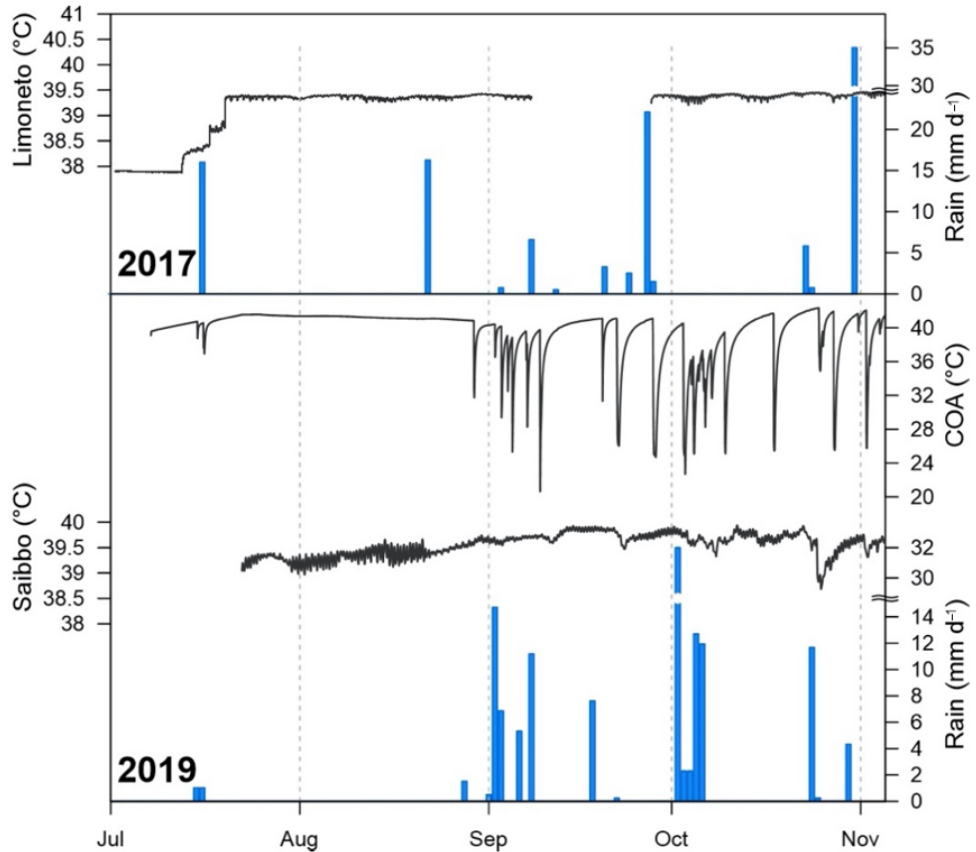
Figure 10. Hourly measures of the groundwater temperature acquired at wells LIM (2017), COA, and SAI (2019) compared with rainfall (mm d − 1 ). The time window covers the period of July–October of different years due to the lack of simultaneous data for the three wells.